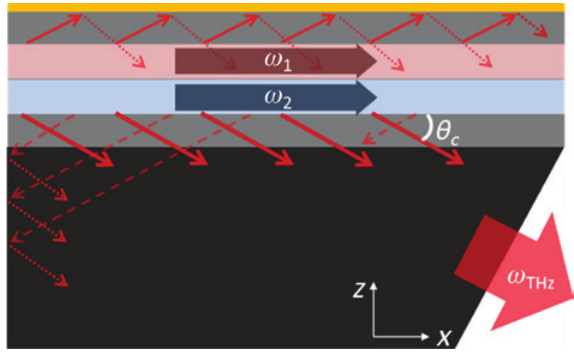
Figure 2: Schematic of the Cherenkov THz DFG-QCL. Red arrows indicate the Cherenkov radiation emitting towards the top metal contact and the bottom InP substrate with an angle of θ . Mid-IR pumps are indicated as ω C starting from the top, gold (yellow), upper cladding layer (light grey), active region (red and blue), lower cladding layer and current injection layer (light grey), and SI InP substrate (dark